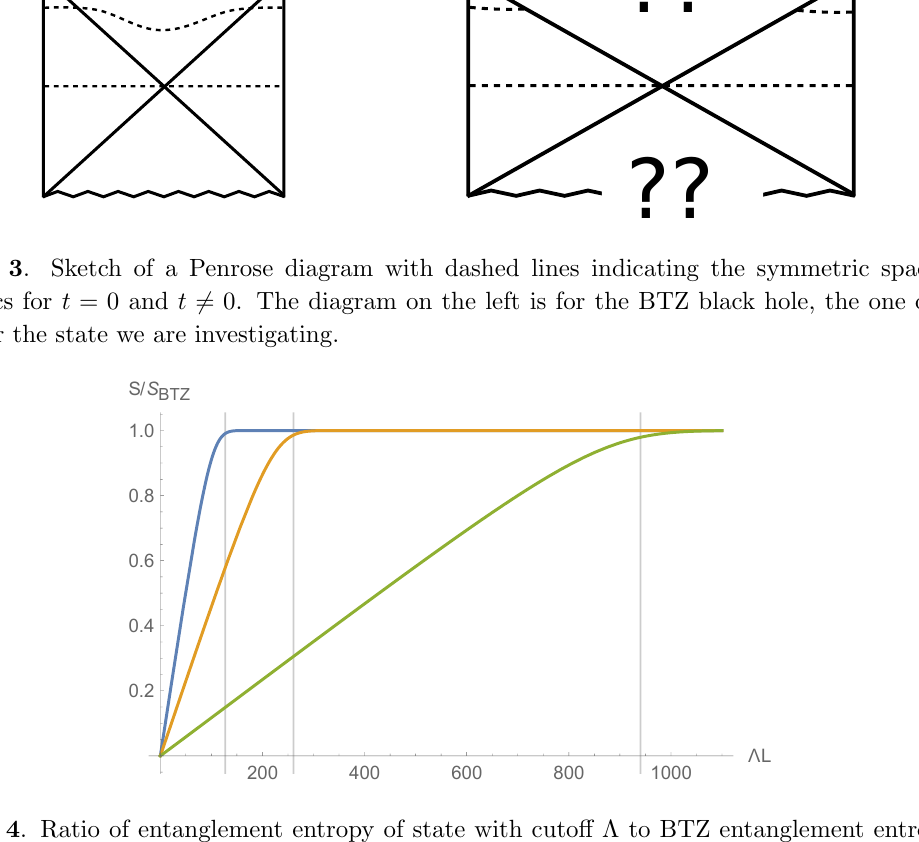
Figure 4 . Ratio of entanglement entropy of state with cuto(cid:11) (cid:3) to BTZ entanglement entropy of the same (cid:12) . c = 100. The blue curve is (cid:12)=L = 3 = 4, the orange (cid:12)=L = 1 = 2 and the green (cid:12)=L = 1 = 4. The vertical lines correspond to a value of the cuto(cid:11) where a saddle-point approximation predicts that the ratio should